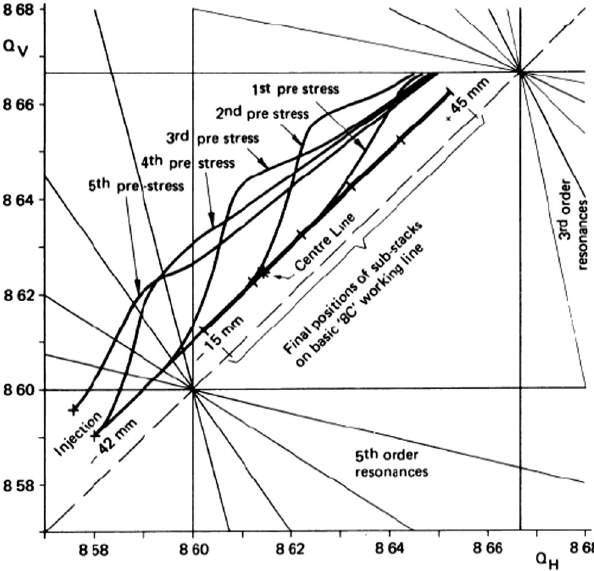
FIG. 8. Working line and space charge compensation.